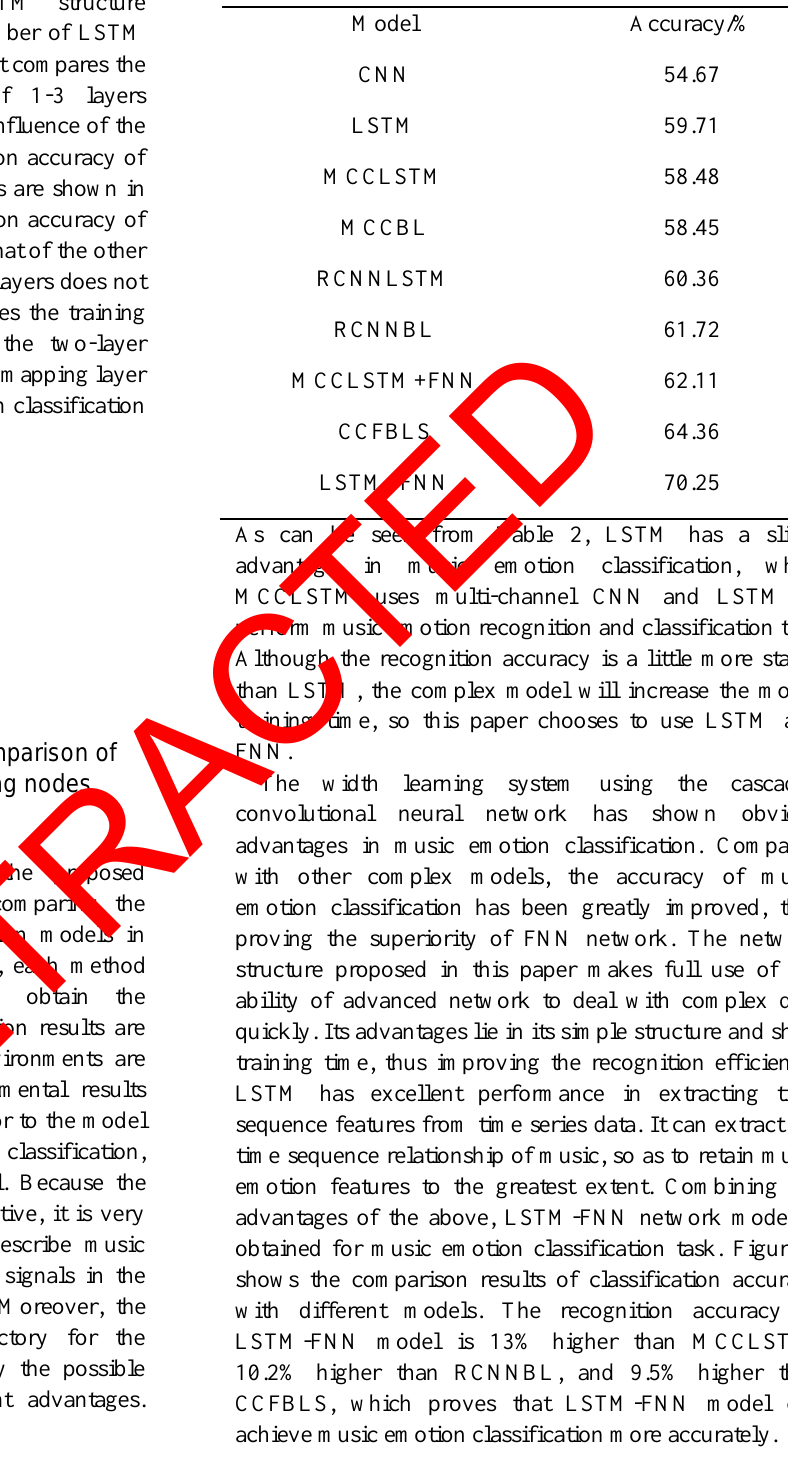
Table 2. Classification accuracy comparison with different